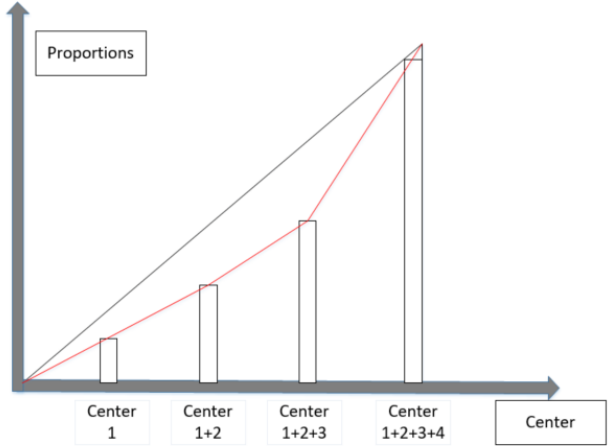
Figure 8. Gini coefficient of all shelters.